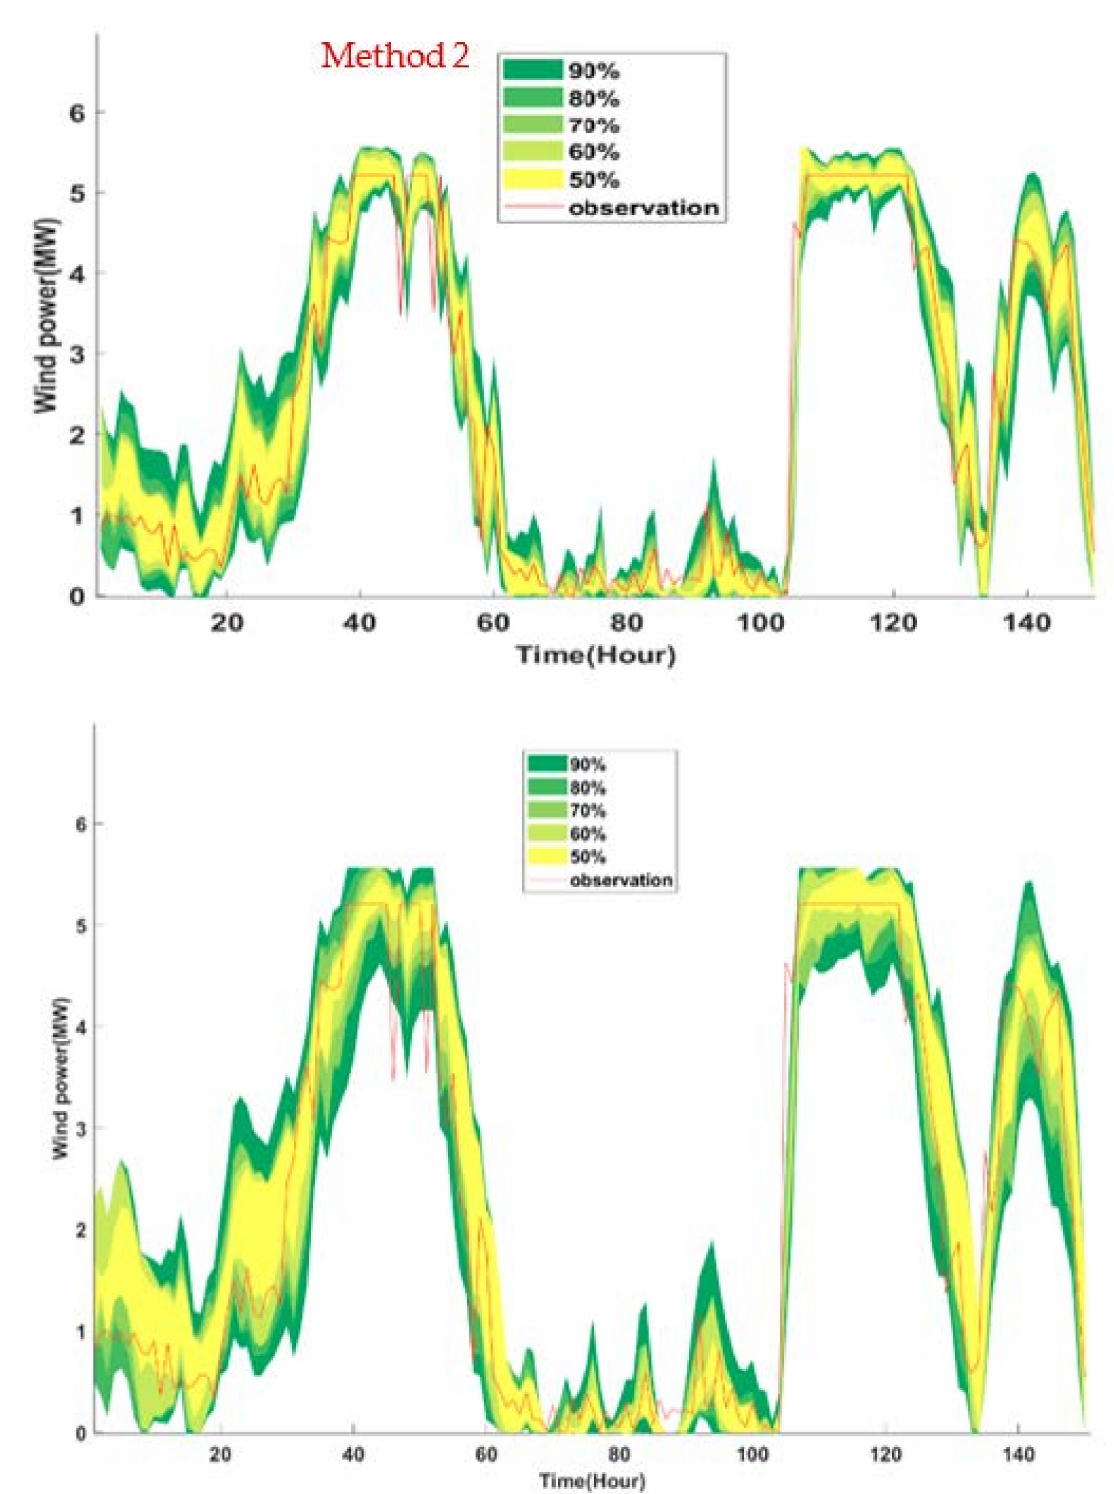
Figure 15. Comparison of wind power forecasting results by the proposed method and Method